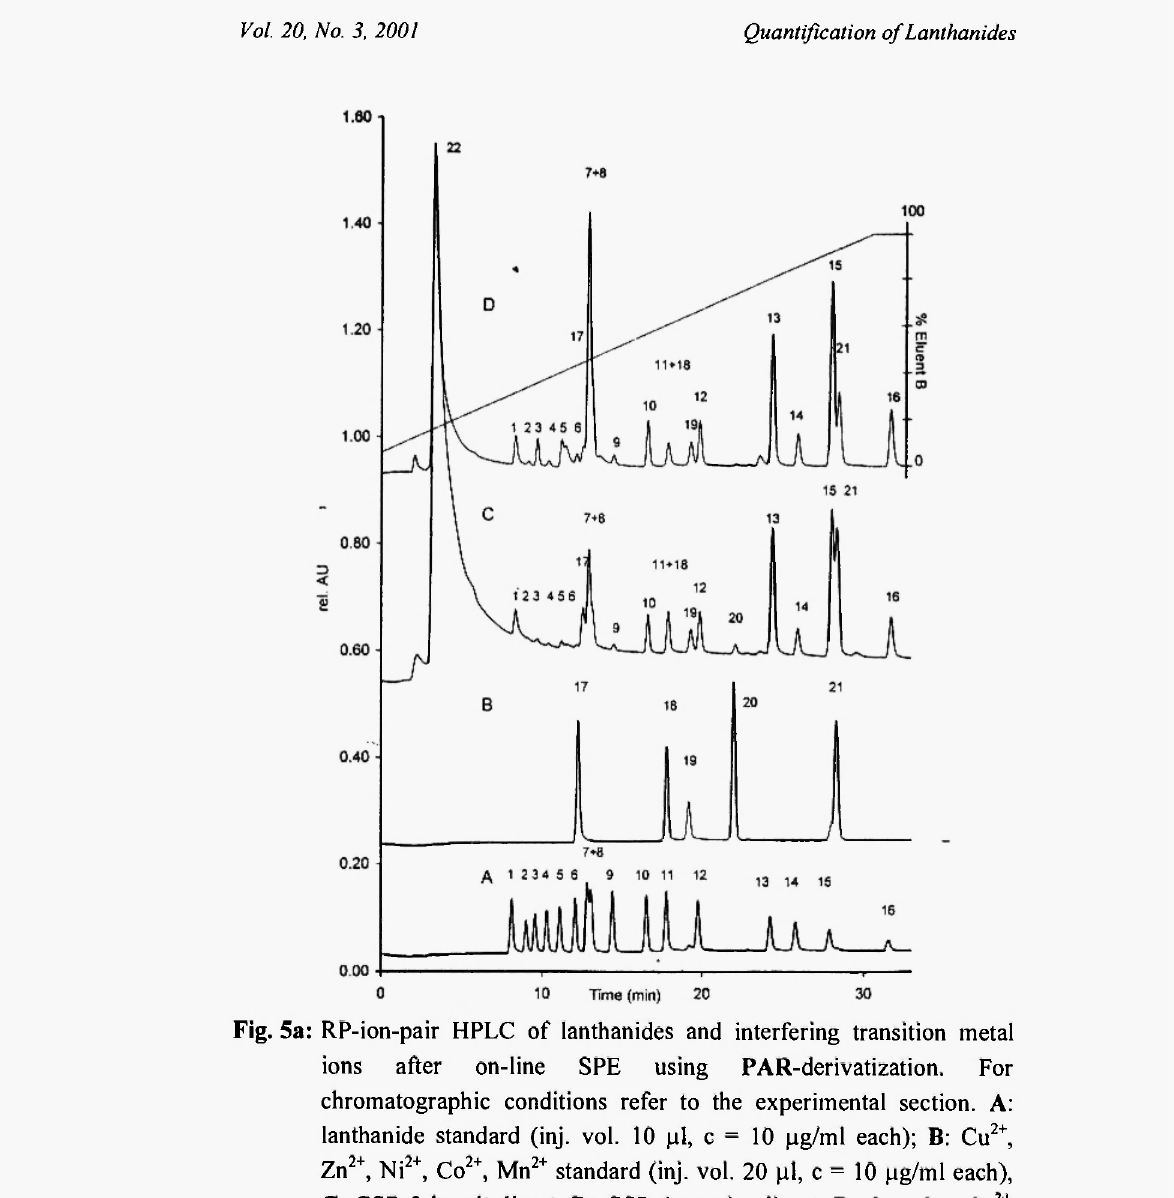
Fig. 5a: RP-ion-pair HPLC of lanthanides and interfering transition metal ions after on-line SPE using PAR -derivatization.